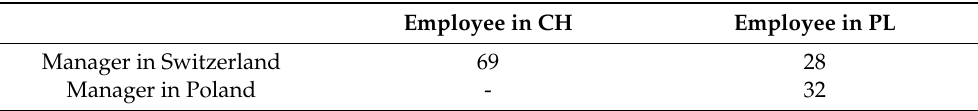
Table 3. Number of respondents by location and manager location.